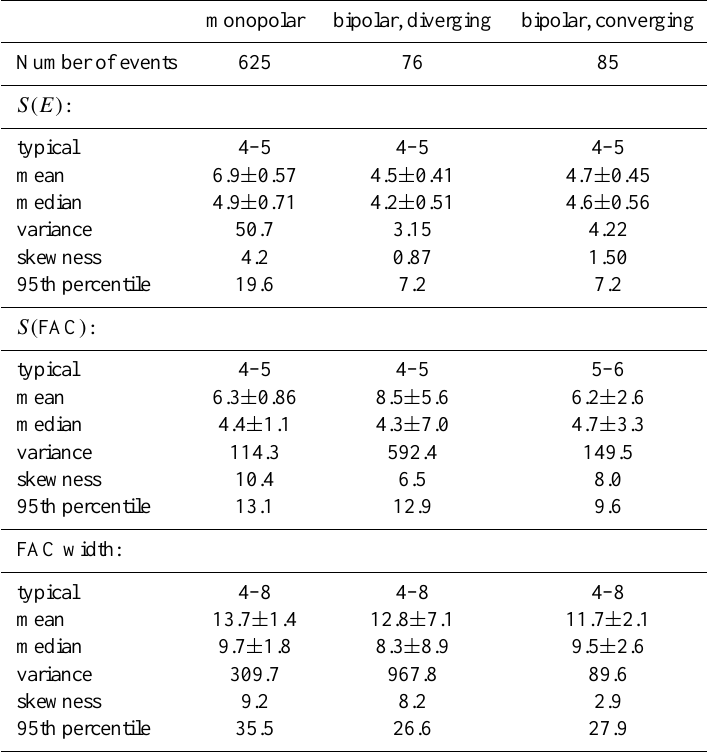
Table 1. Some statistical properties for the electric field scale size, S(E) , and the field-aligned current scale size, S( FAC ) , and the FAC width. The results are separated for different types of electric fields. The values are mapped down to ionospheric altitude for reference and given in km. 11 events could neither be labelled monopolar nor bipolar by the routine used. For median and mean values, errors using the 95.5% confidence interval are